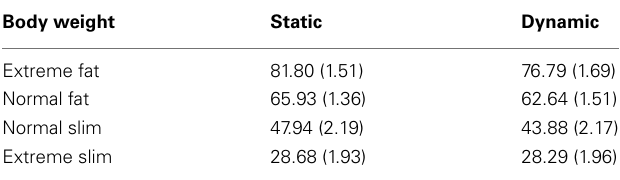
Table 1 | Mean and standard error of mean (in brackets) for fatness judgment of body shape as a function of implied motion (static/dynamic) and body weight (extreme fat, normal fat, normal slim, and extreme